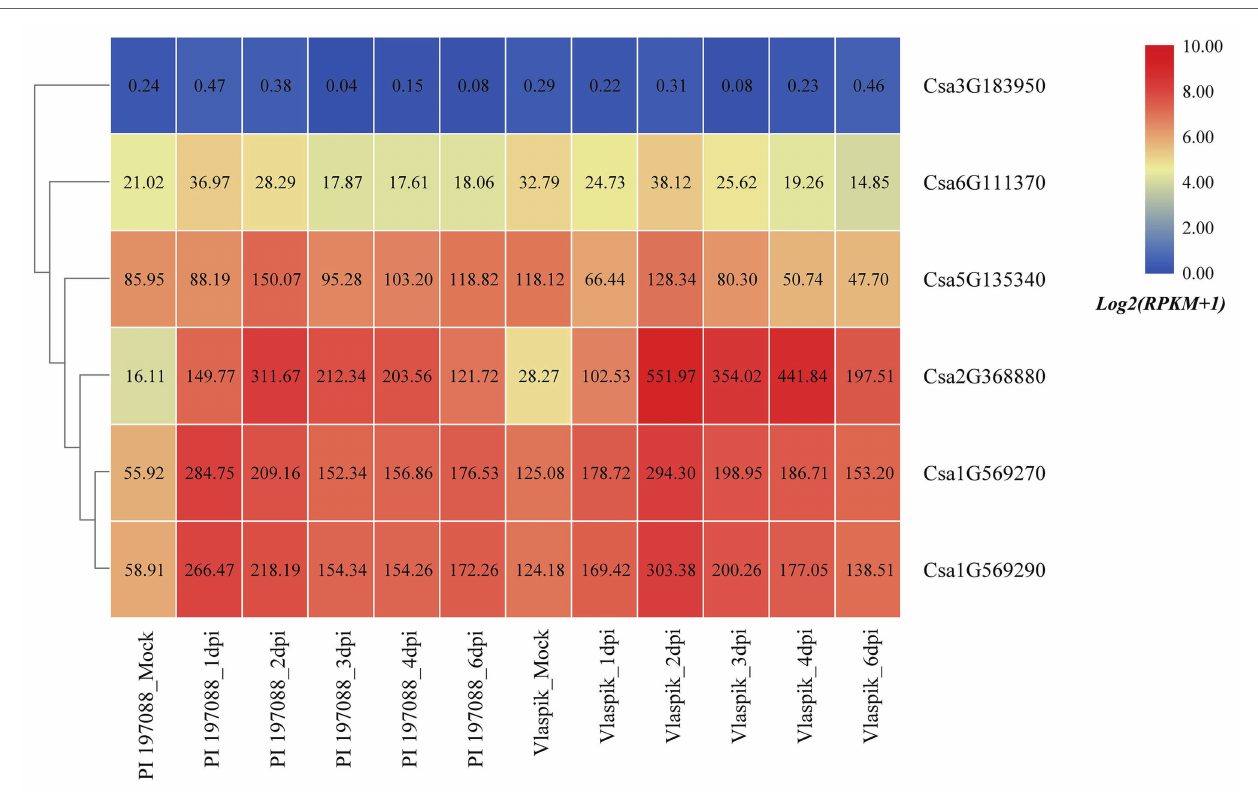
FIGURE 9 | The expression heatmap of the cucumber HSP90 gene family under the treatment of downy mildew inoculation. PI 197088 is the downy mildew resistant cucumber plant; Vlaspik is the downy mildew susceptible cucumber plant. Mock is the control sample. dpi means the days post inoculation. The data in the boxes indicate original RPKM